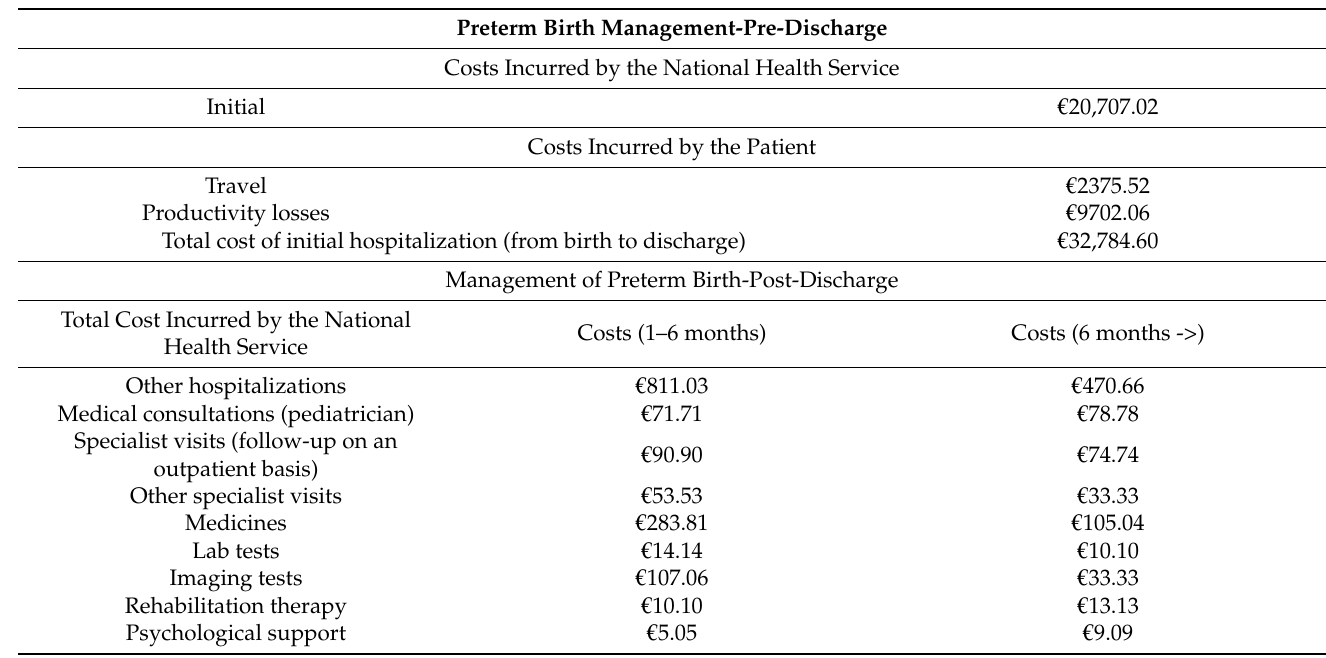
Table 7. Preterm birth management costs (pre- and post-discharge)